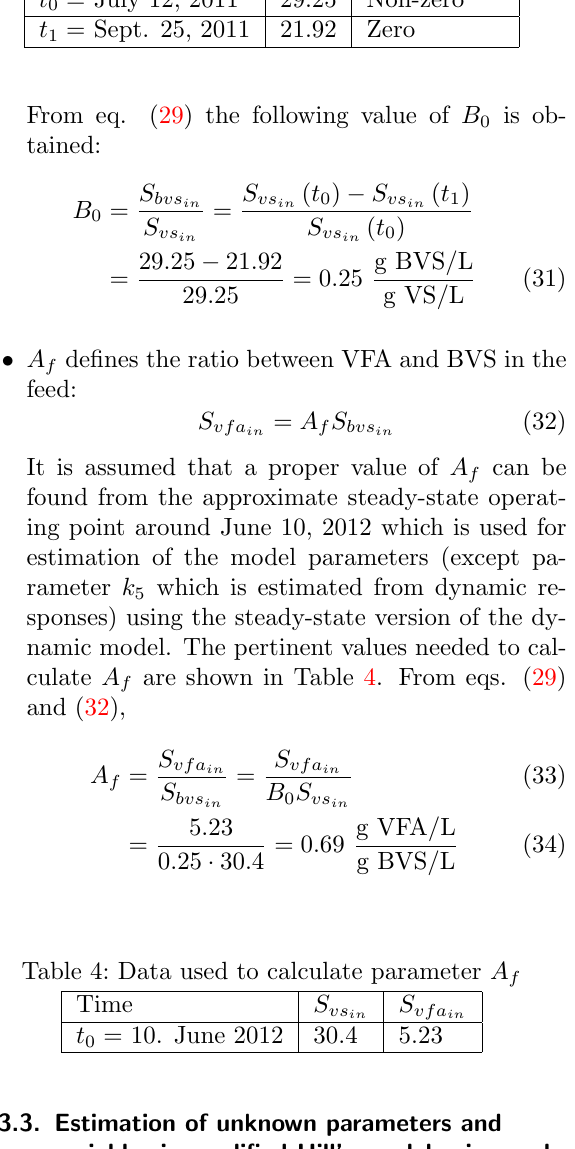
Table 3: Long-term test to find parameter B 0 Time S vs